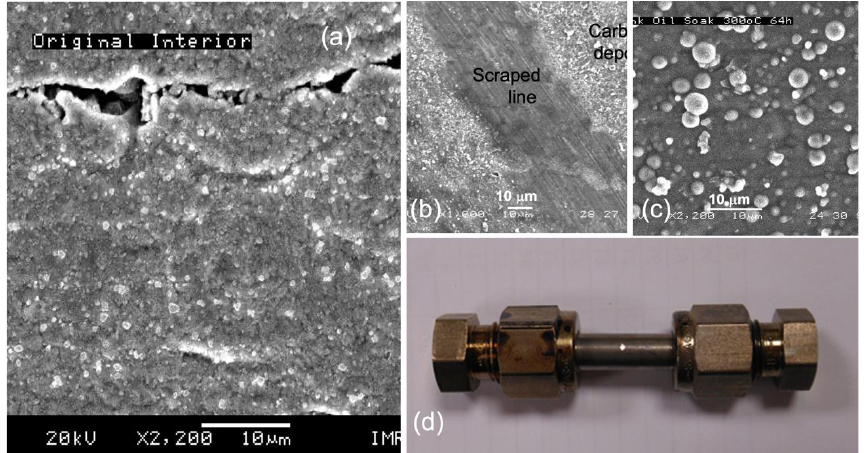
Figure 5. SEM images of ( a ) the interior tube wall of the crude SS-321 tube, ( b ) a coke layer deposited on the above surface after heating the lubricant sealed in the tube at 300 ◦ C for 64 h, ( c ) an amplified view of the coke layer, and ( d ) the photo of the tube enclosing the aerospace